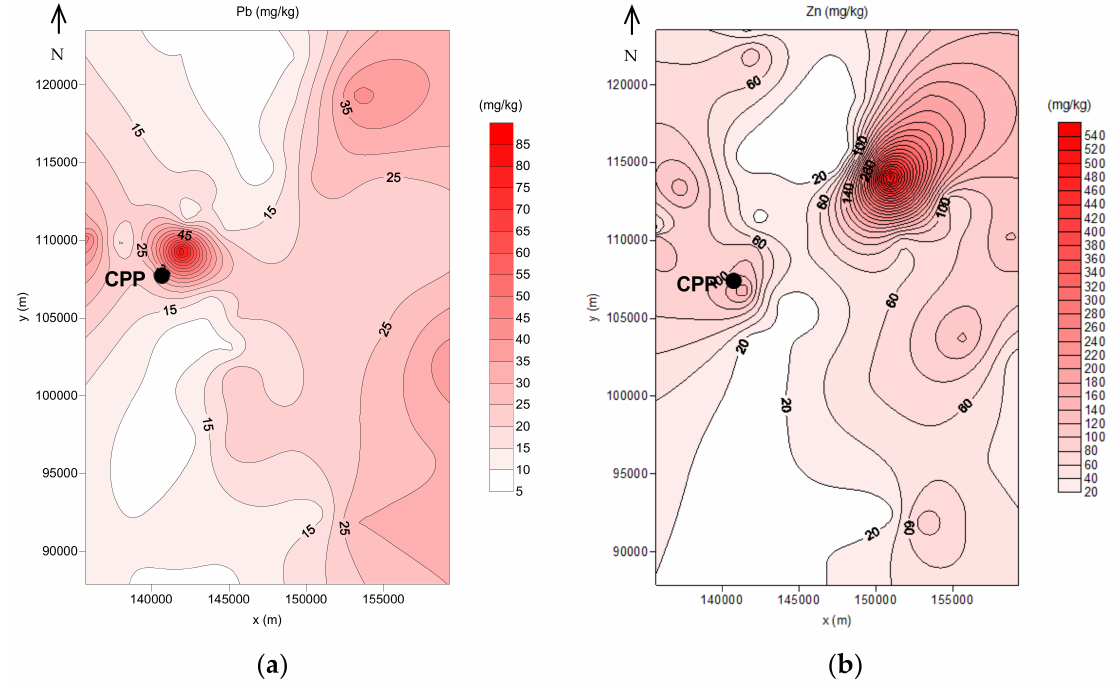
Figure 6. Iso-concentration maps (SC1): ( a ) Pb and ( b )